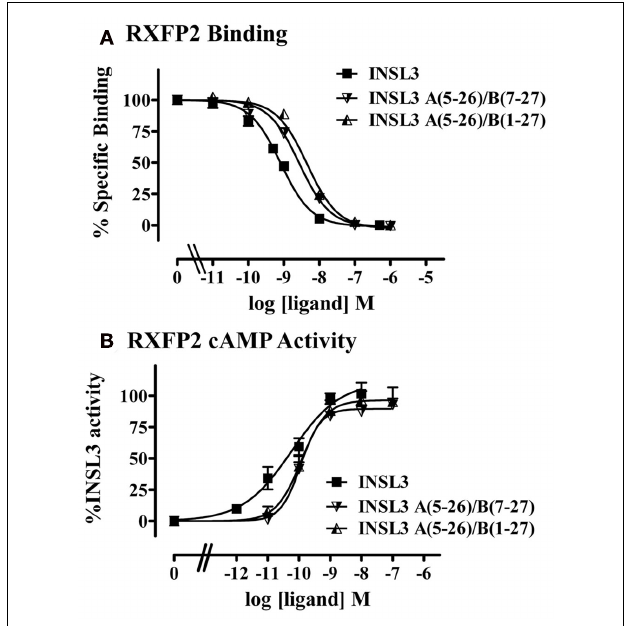
FIGURE 7 |Activity of INSL3 truncated peptides on the RXFP2 receptor. (A) Competition binding utilizing Eu-labeled INSL3 compared to INSL3 and H2 relaxin. Data are expressed as the percentage of specific binding and are pooled from at least three experiments with triplicate determinations within each assay. (B) cAMP activity compared to INSL3 and H2 relaxin measured utilizing a pCRE– β -galactosidase reporter gene assay. Data are expressed as the percentage INSL3 maximum activity and are pooled data from at least three experiments with triplicate determinations within each